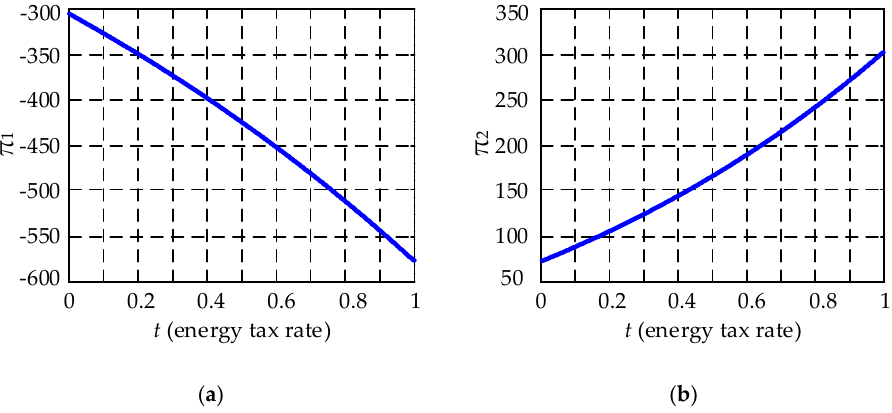
Figure 4. Simulation results of profit: ( a ) Profit of Firm 1 vs. the energy tax rate; ( b ) profit of Firm 2 vs. the energy tax rate.